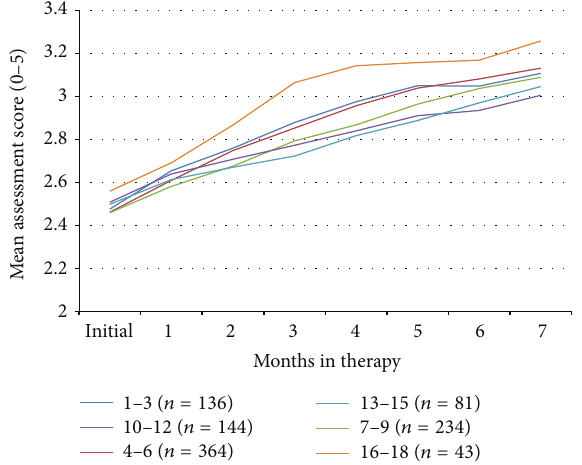
Figure 4: Mean composite assessment score (scale 0–5) over time for subjects of different ages.